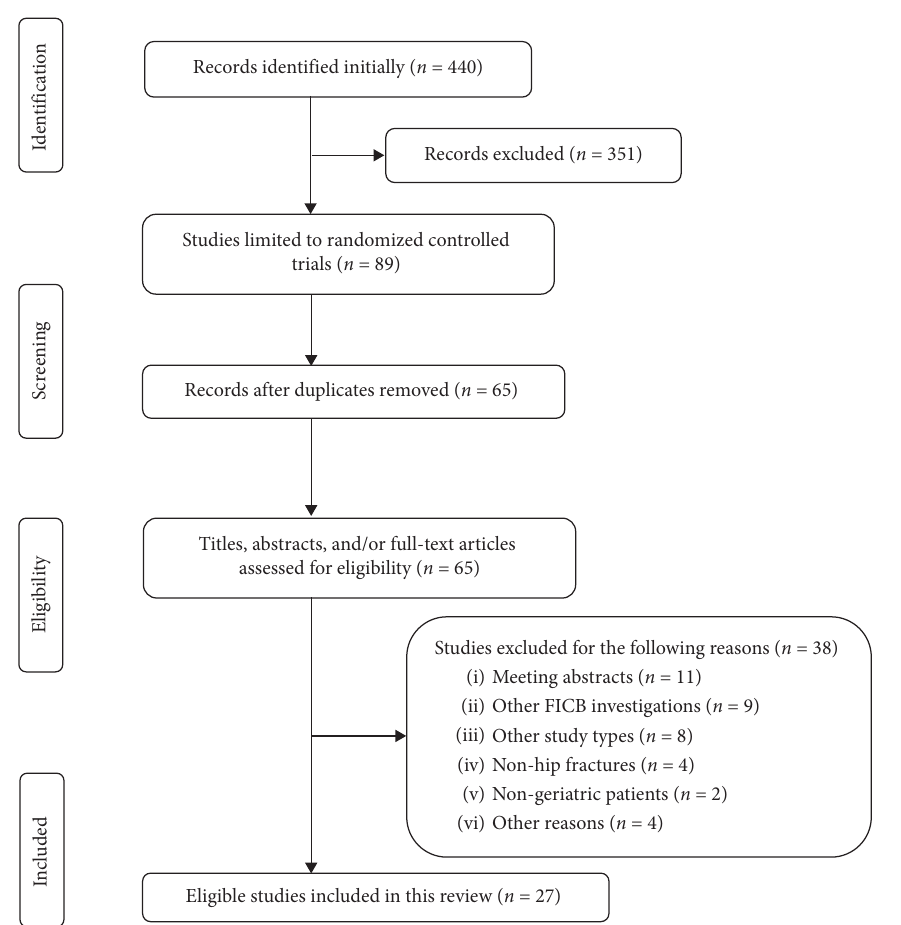
Figure 1: Preferred reporting items for systematic reviews and meta-analyses flow